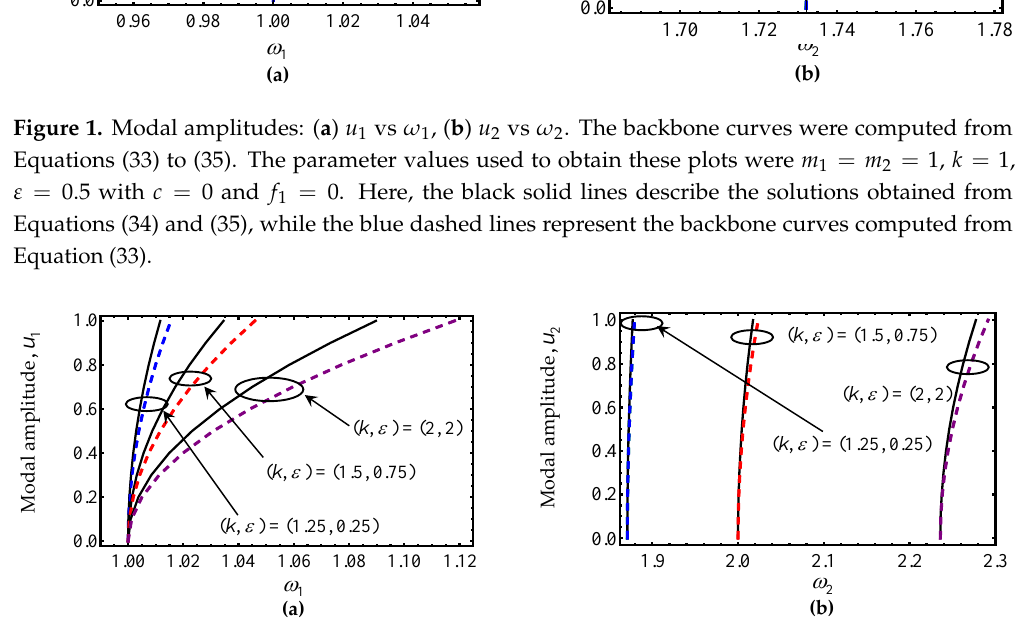
Figure 2. Modal amplitudes: ( a ) u 1 vs ω 1 , ( b ) u 2 vs ω 2 . The backbone curves were computed from Equations (33) to (35). The parameter values used to obtain these plots for different values of k and ε were m 1 = m 2 = 1, with c = 0 and f 1 = 0. Here, the black solid lines describe the solutions obtained from Equations (34) and (35), while the colored, dashed lines represent the backbone curves computed from Equation (33).